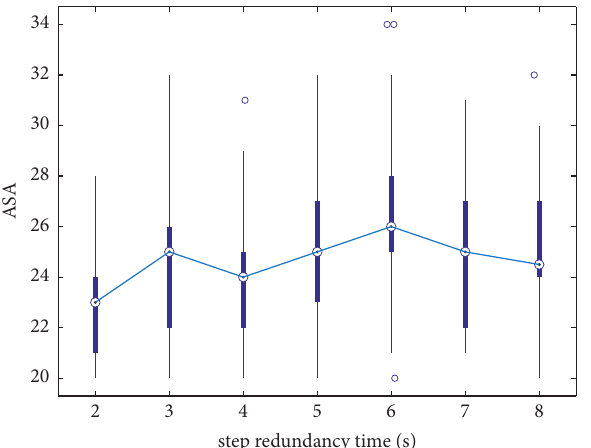
Figure 7: The influence of stepping redundancy time on the demand of auxiliary stopping area. The line connects the median value of the number of ASA on each redundancy time. The thin blue line represents the total value range that 30-time results appear not considered outliers; the bottom and top edges of the thick blue line indicate the 25 th and 75 th percentiles, respectively; and the outliers are plotted individually using the “ o ”